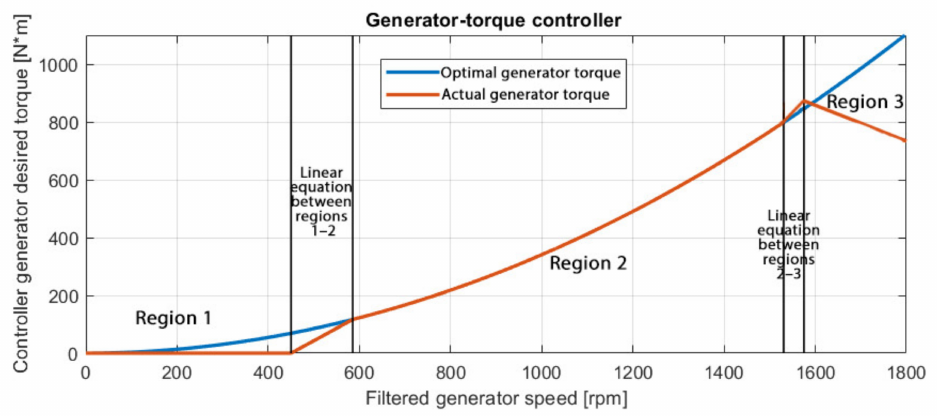
Figure 4. Generator-torque controller